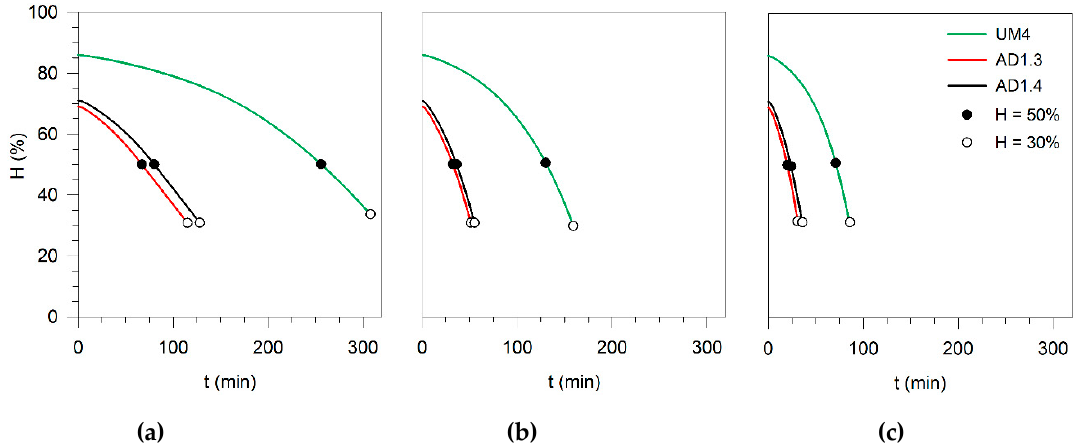
Figure 3. Moisture profile of UM4, AD1.3, and AD1.4 samples at: (a ) 70 °C, ( b ) 100 °C, and ( c ) 130 °C.